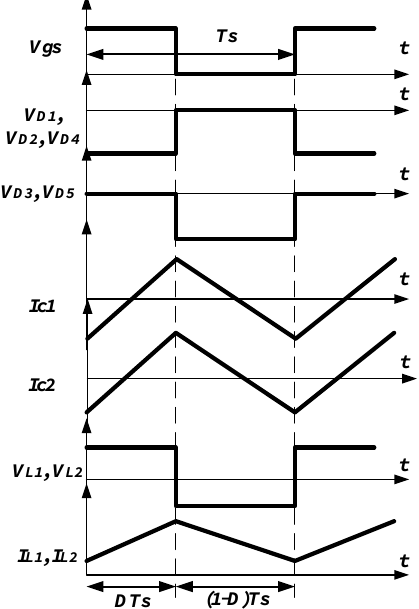
Figure 4. Switching voltage for the power switch, voltage across the diodes, current for the capacitors, and voltage and current for the inductors in a switching time period.